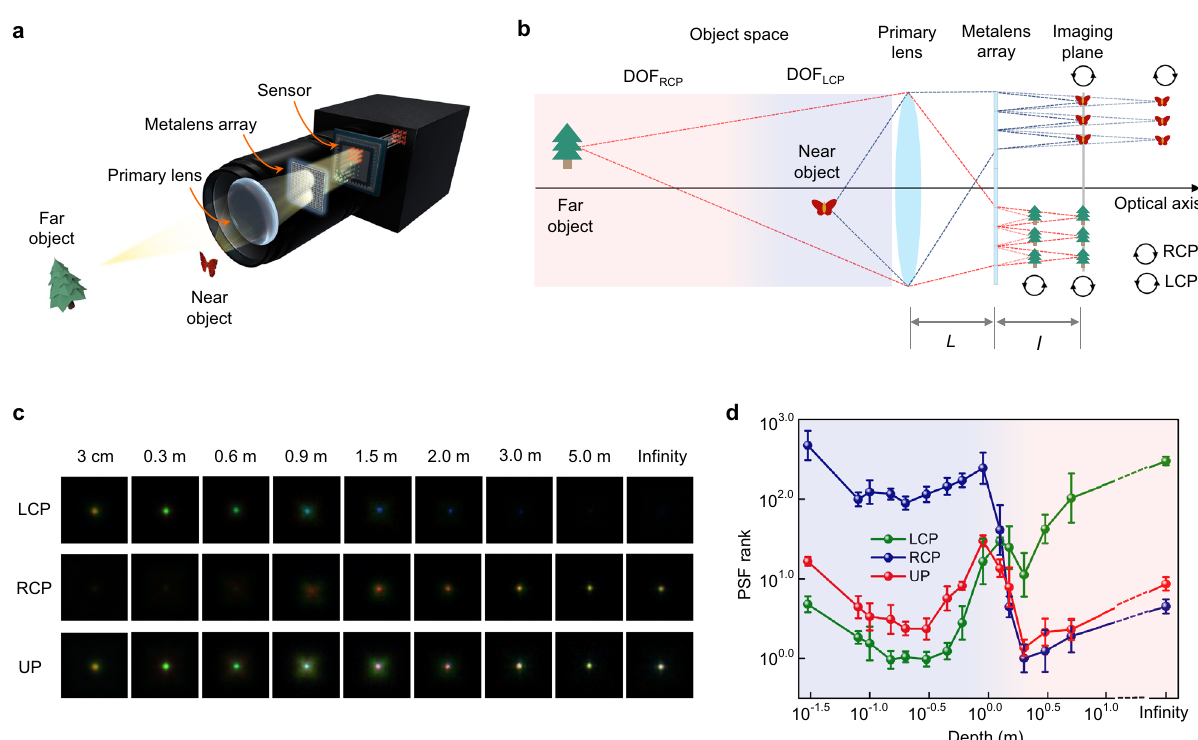
Fig. 3 Light- fi eld imaging system enabled by the spin-multiplexed metalens array. a Conceptual sketch of the proposed light- fi eld imaging camera. b Schematic diagram of the working principle of the system with metalens array achieving spin-dependent bifocal light- fi eld imaging. Either the LCP component of close object or the RCP component of distant object could be focused well on the identical imaging plane. The nominal distance between the primary lens and metalens array is L ¼ 47 : 5 mm. The nominal distance between the imaging plane and metalens array is l ¼ 0 : 83 mm. The focal length and aperture size of the primary lens is F ¼ 50 mm and D ¼ 6 mm, respectively. c The captured PSFs at different depths for LCP, RCP, and UP (unpolarized) incident light. d Demonstration of working range for different polarization states. The light-blue region and light-red region represent the working range of LCP and RCP components, respectively. The vertical axis represents the PSF ranks, for which the smaller value corresponds to better imaging quality. The uncertainties are standard deviation for repeated measurements (six in